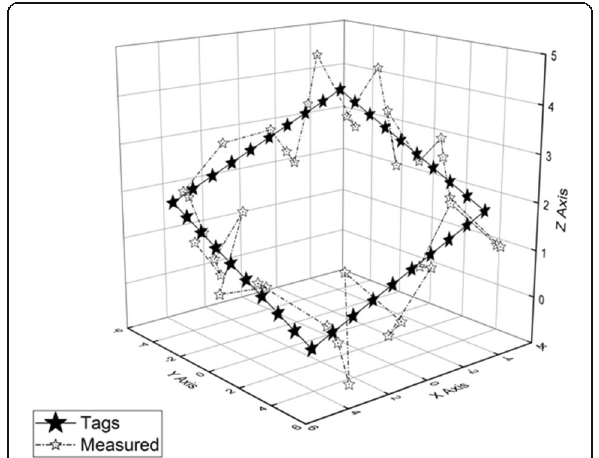
Fig. 14 3D indoor localization optimization. After modeling, we optimize the measured target by our proposed ELPSO algorithm to achieve the optimal localization, which is represented by the red dots. The specific localization coordinates are listed in Table 5